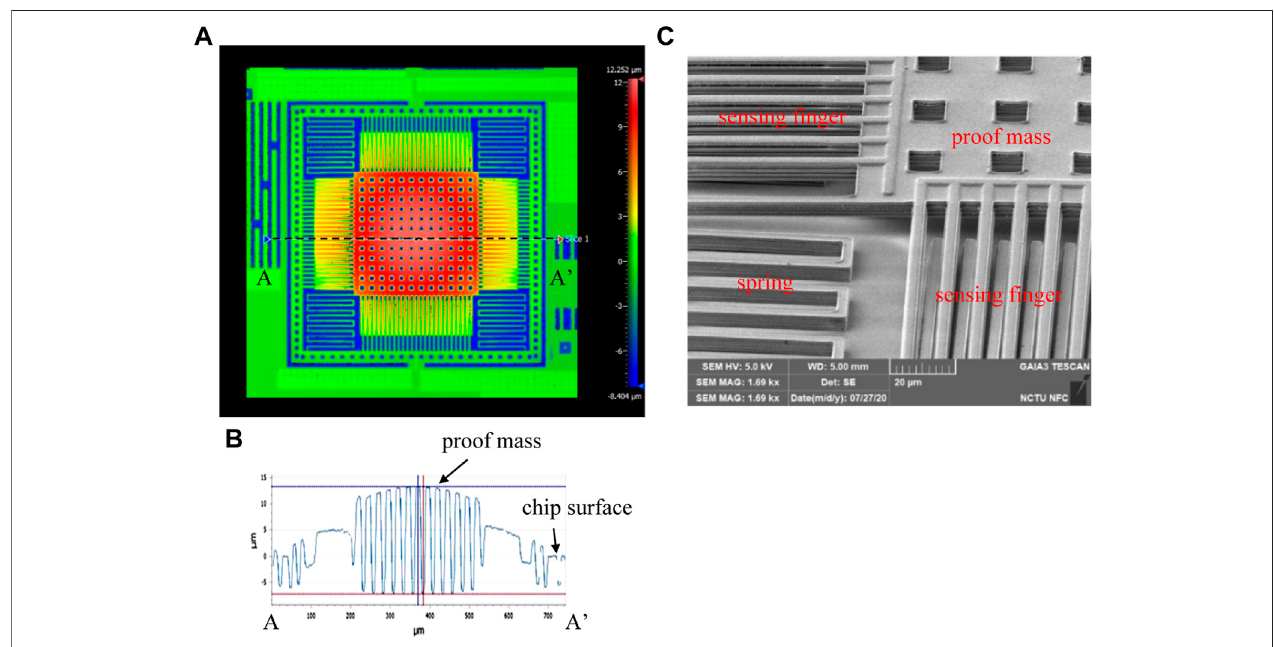
FIGURE14 |(A) White light interferometric measurement ofthe surface topology ofa released device, (B) linescan ofsurface height through AA ′ , (C) SEMviewof suspended proof mass and bent down spring.